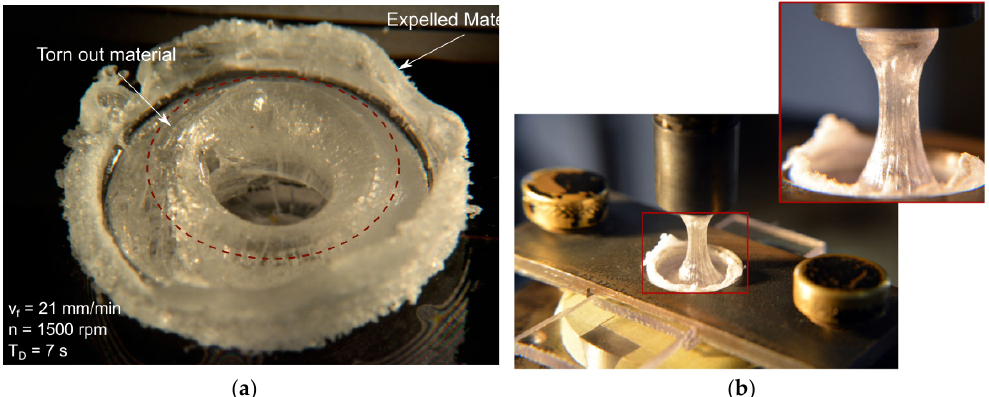
Figure 33. ( a ) Tearing out effect [75] and ( b ) material attached to the tool owing to highly insufficient waiting time [76].